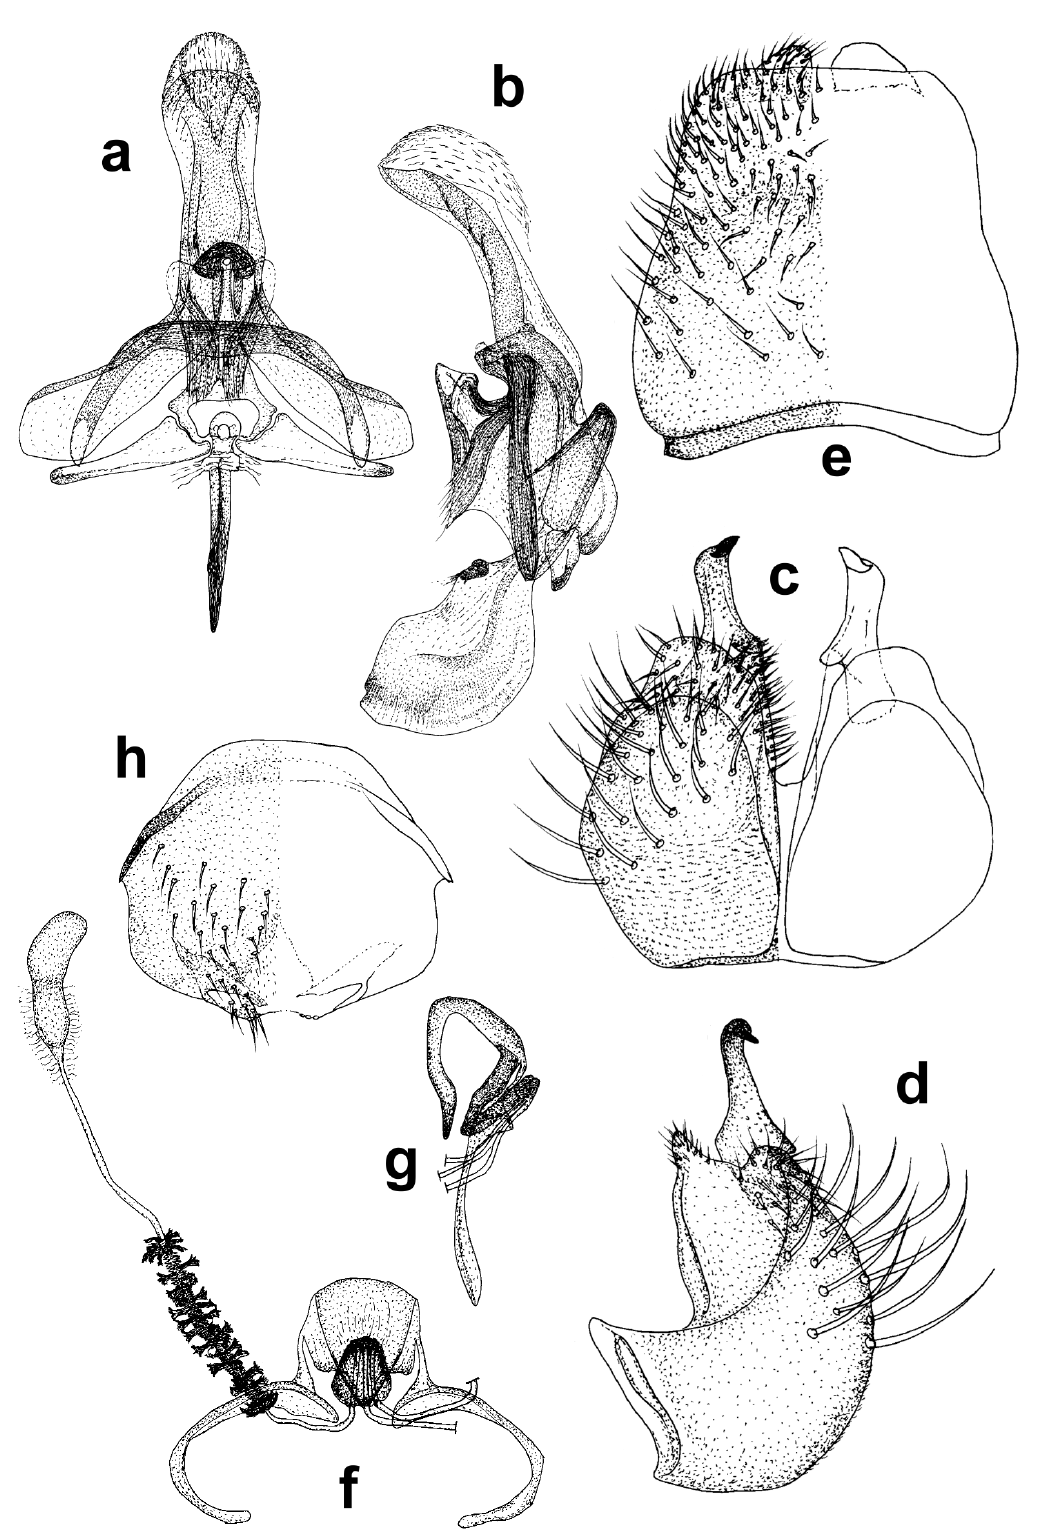
Fig. 52. Protypusia negevi (Zaitzev, 1996) gen. et comb. nov. a . Epiphallic complex ventral. b . Epiphallic complex lateral. c . Gonocoxite ventral. d . Gonocoxite lateral. e . Epandrium dorsal. f . Female genitalia ventral. g . Female genitalia lateral. h . Female sternite 8